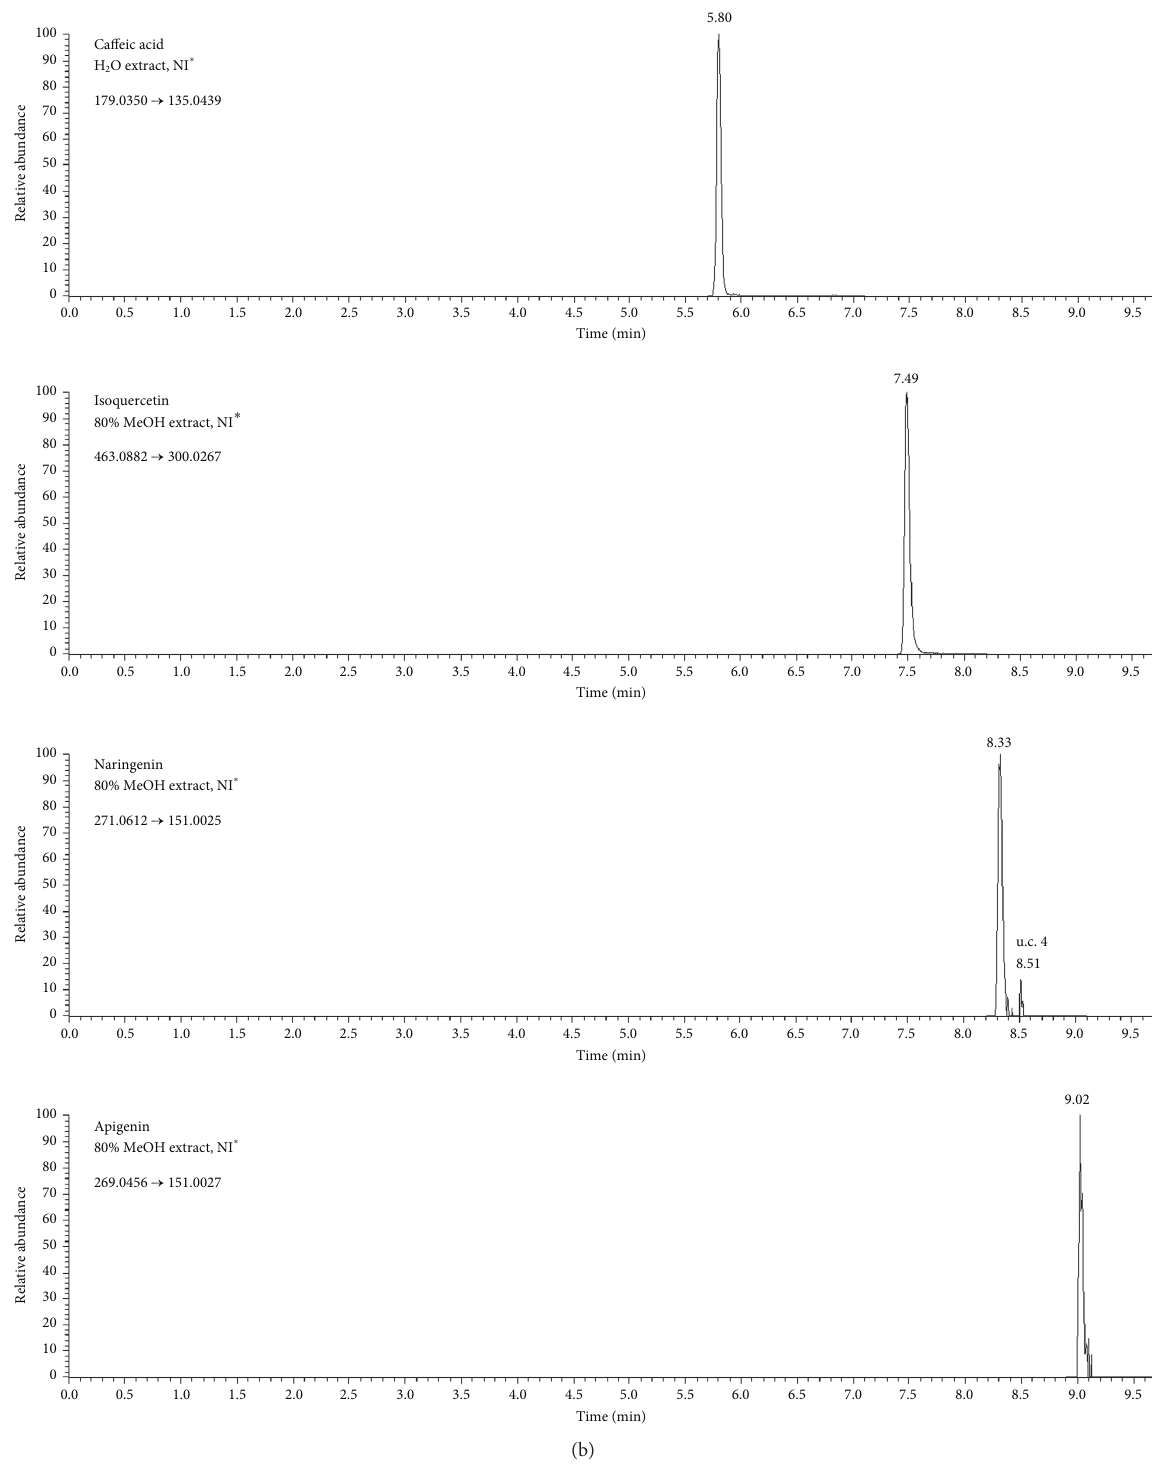
Figure 1: Analysis of phenolic compounds in Salacca zalacca fruit pulp by UHPLC-HRMS/MS with MS/MS spectrometer operating in PRM (parallel reaction monitoring) mode. Note: each PRM transition is described by name of corresponding compound and characterized by its retention time, and m/z values of respective precursor ion and product ion. u.c.—unknown compound. PI ∗ —positive ionization; NI ∗ —negative